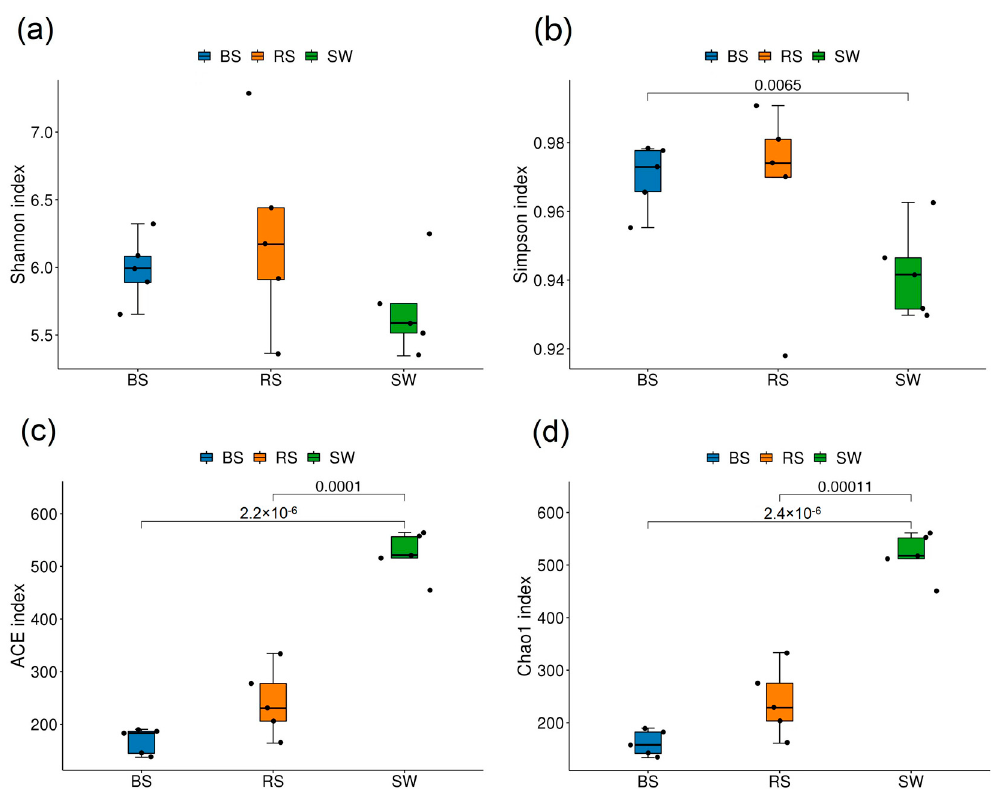
Figure 2. Alpha diversity of fungal community. RS: the seagrass rhizosphere soil samples; BS: sediment samples; SW: seawater samples. ( a ): Shannon index; ( b ): Simpson index; ( c ): ACE index; ( d ): Chao1 index. Different colored squares represent different groups. Statistical analysis was performed using the student’s t -test.